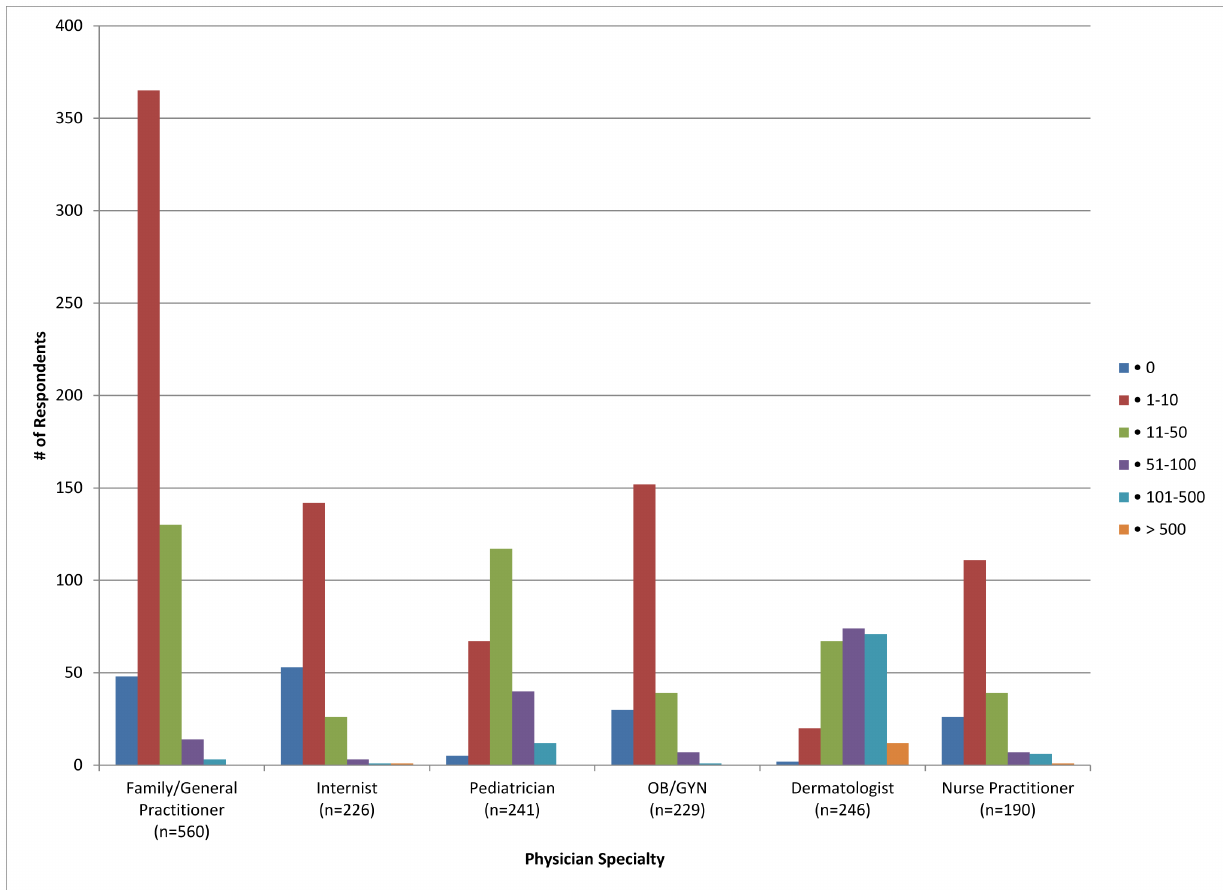
Figure 1. Number of molluscum contagiosum cases seen in the last one year for each specialty.